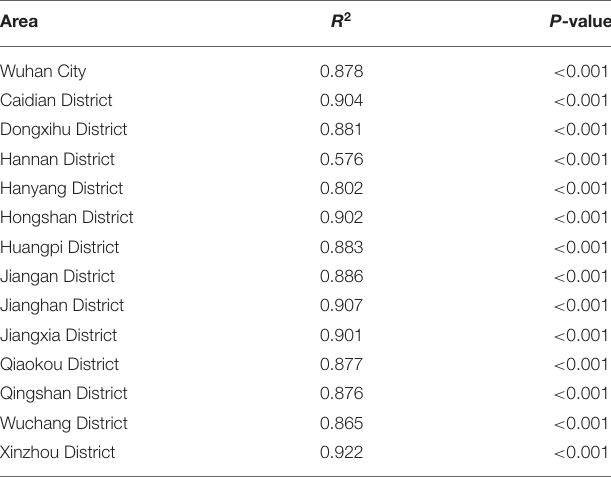
TABLE 2 | Goodness-of-fit test for Wuhan City and its 13